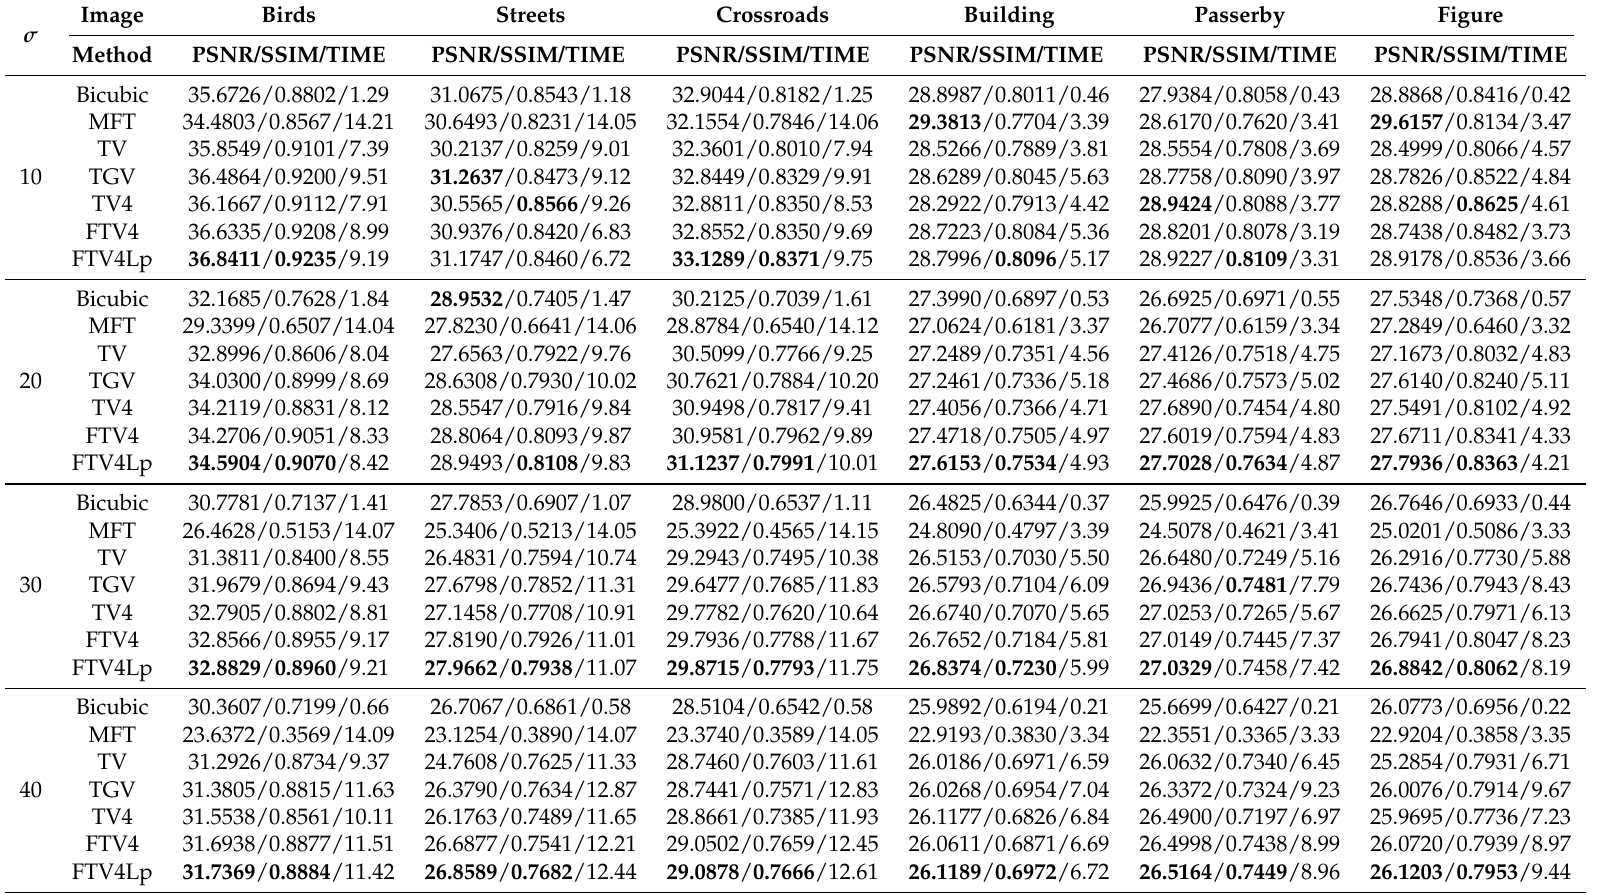
Table 2. Infrared image super-resolution x2 experiment with added white Gaussian